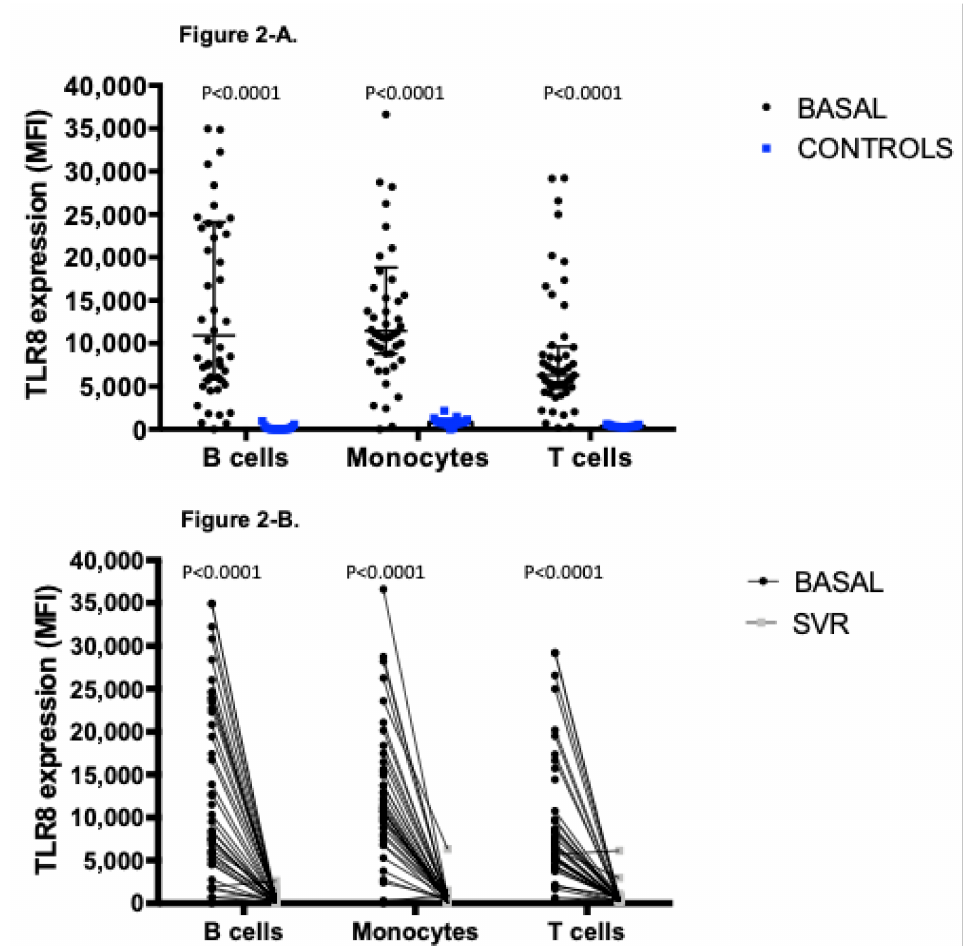
Figure 2. ( A ). TLR8 expression profile measured as mean fluorescence intensity (MFI) (median (interquartile range [IQR])) in B cells, monocytes, and T cells in hepatitis C infection (HCV) patients and healthy controls: TLR8 in B cells in